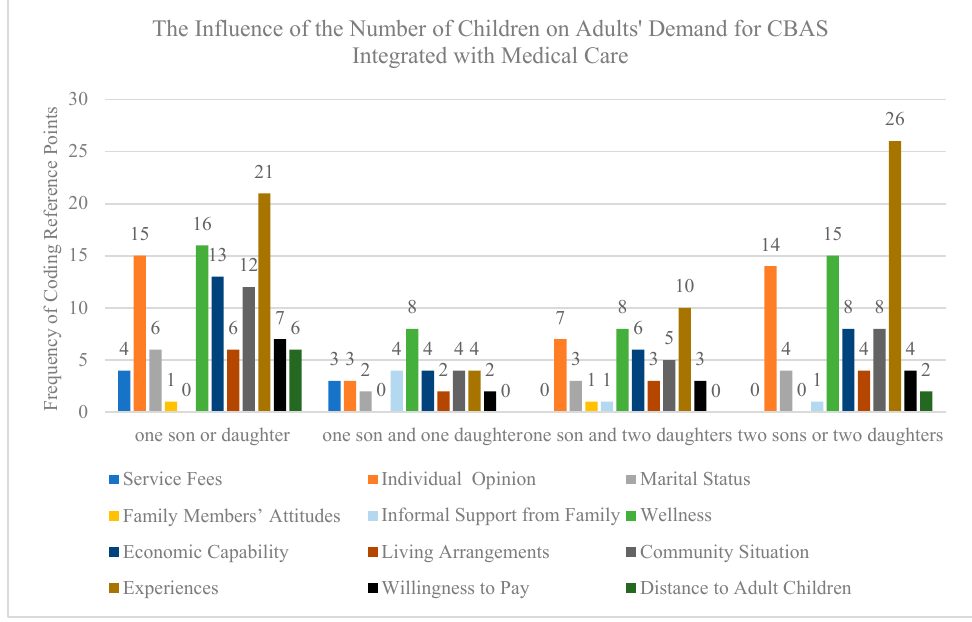
Figure A2. Difference in the factors influencing demand for CBAS integrated with medical care by number of children.